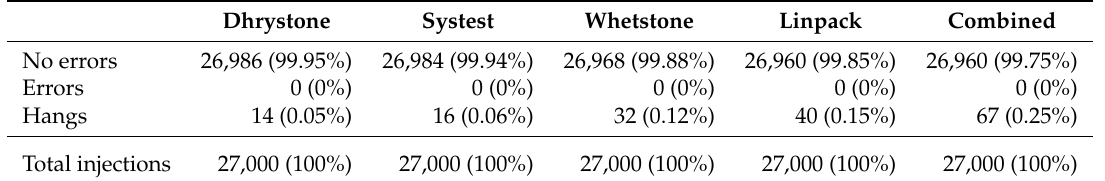
Table 4. Reliability results for the DTMR-protected version of the Rocket RISC-V